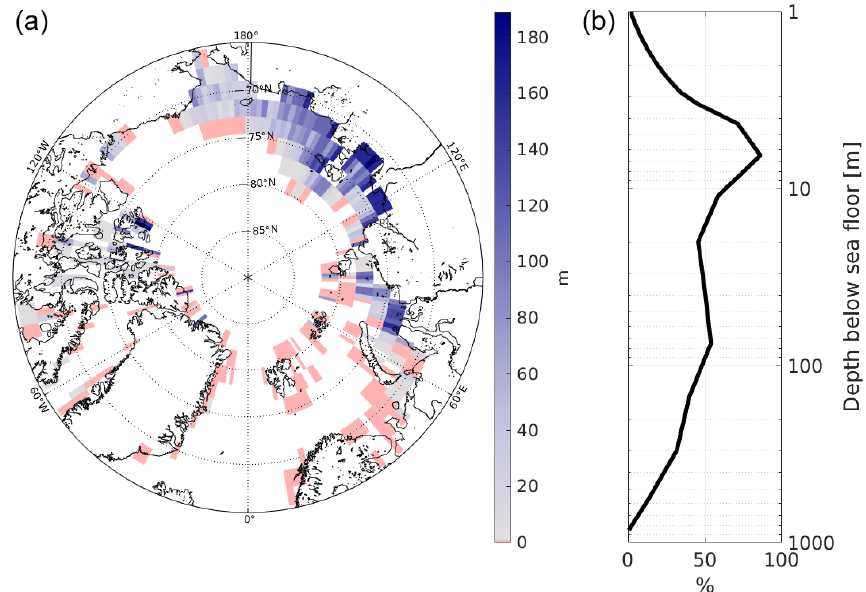
Figure 1. (a) Length of initial (1850) SSPF ice column. Reddish colour marks points entirely without ice in the sediments. (b) Vertical distribution of initial ice concentration in sediment pore space (SSPF ice saturation). Panel (b) shows the spatial average over the area containing SSPF ice in